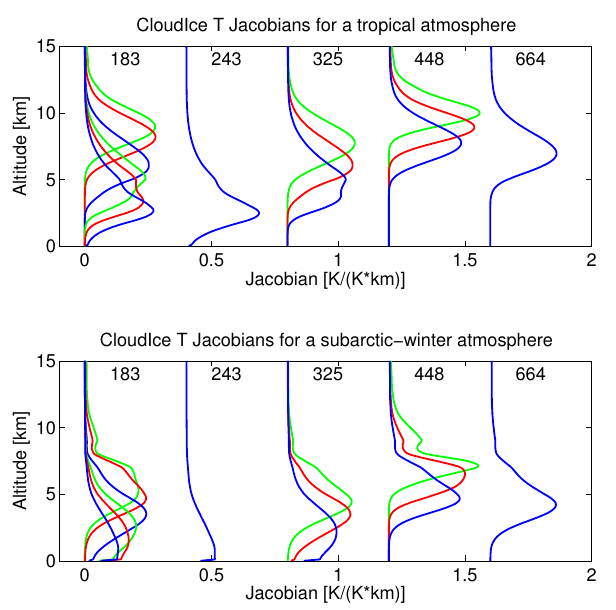
Fig. 4. CloudIce temperature Jacobians for a tropical atmosphere (top panel) and a subarctic-winter atmosphere (bottom panel). These are the derivatives of the measurement with respect to changes in the atmospheric temperature at different altitudes. The Jacobians indicate the measurement altitude of the different chan- nels. Jacobians for different radiometers have been shifted to the right by different amounts, so that they all can be displayed in a single graph. The atmospheric scenarios are from Anderson et al. (1986). The assumed surface emissivity is 0.6.